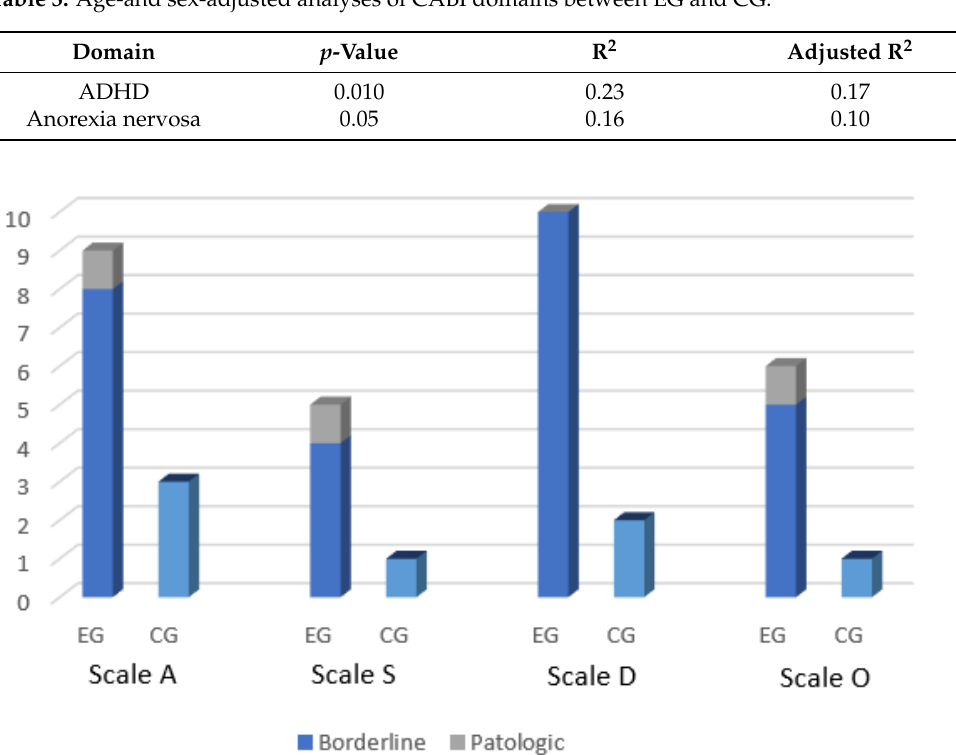
Figure 2. Number of subjects showing borderline or pathological scores in the SAFA scales in the EG and CG.